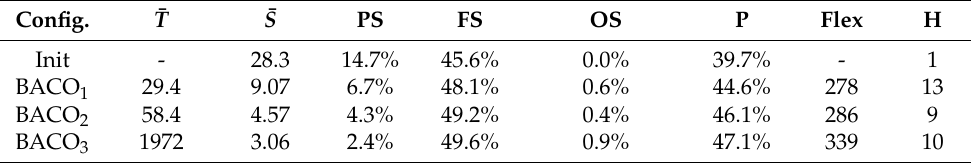
Table 6. Results for algorithm runs within the undersupply scenario. The average time is denoted as ¯ T and the achieved average score as ¯ S . The amount of unsupplied (US), partially supplied (PS), fully supplied (FS), oversupplied (OS), and producer (P) holon objects. Flex denotes the number of used flexibilities and the number of holons is shown as H. Config. ¯ T ¯ S